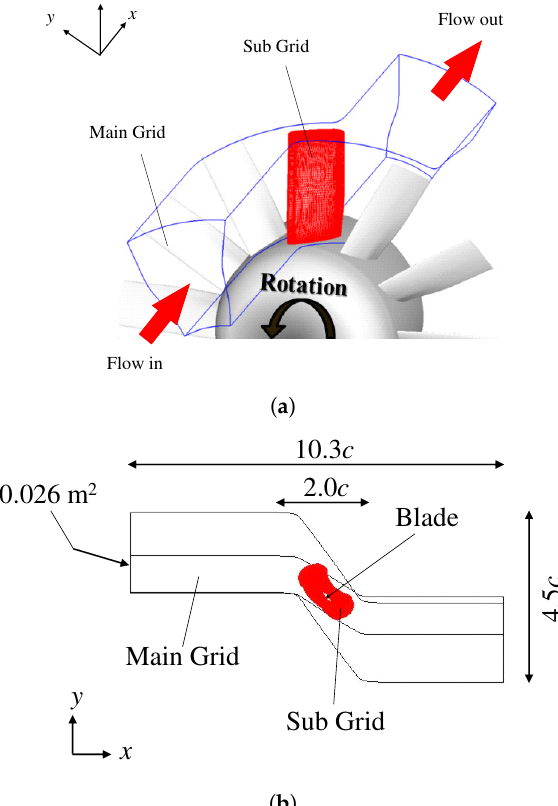
Figure 3. Flow around axial fan and computational domain: the main and sub grids are shown in blue and red, respectively. ( a ) Overview and ( b ) top view of the computational